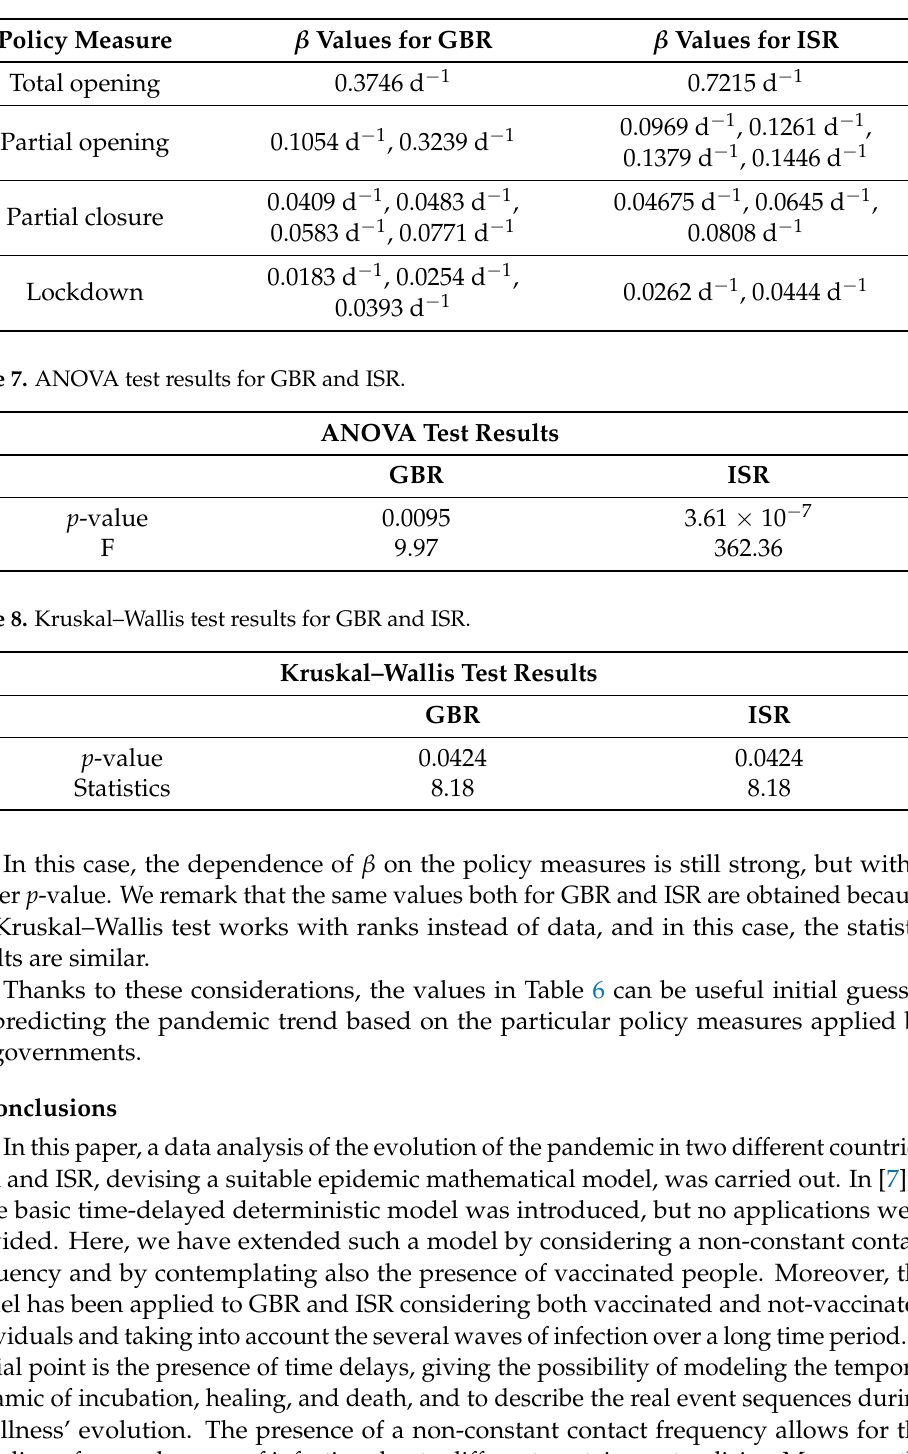
Table 6. β ( t ) values grouped by total opening, partial opening, partial closure, and lockdown for the two countries.